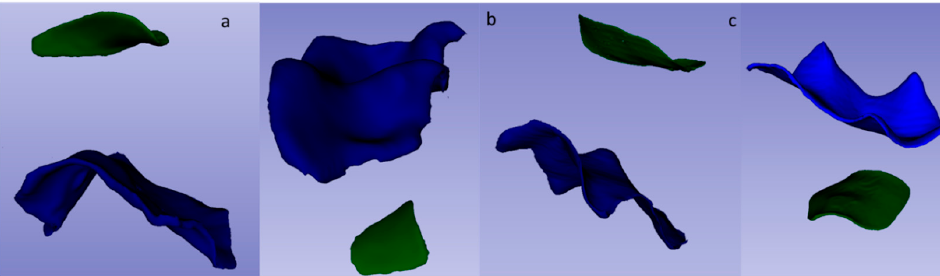
Figure 2. Three-dimensional reconstruction of the roof (in blue) and floor (in green) surfaces of the primary molar pulp chamber: P1MSP( a ); P1MI ( b ); P2MS ( c ) and P2MI ( d ).